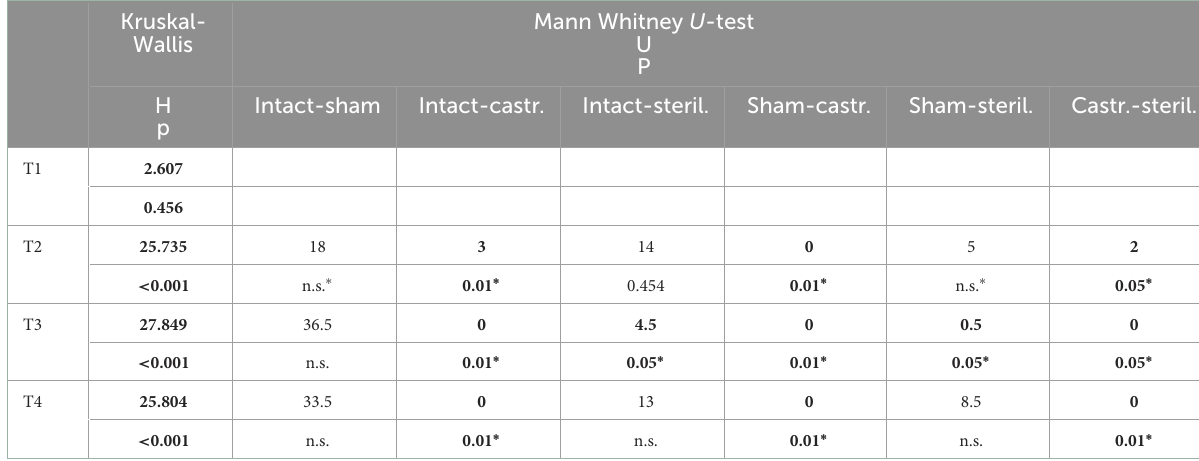
TABLE 1 Statistical parameters of testosterone concentrations of intact ( n = 10), sham-operated ( n = 8), castrated ( n = 14), and sterilized ( n = 4) males. Kruskal- Wallis H Intact-sham Intact-castr. Intact-steril. Sham-castr. Sham-steril. Castr.-steril. p